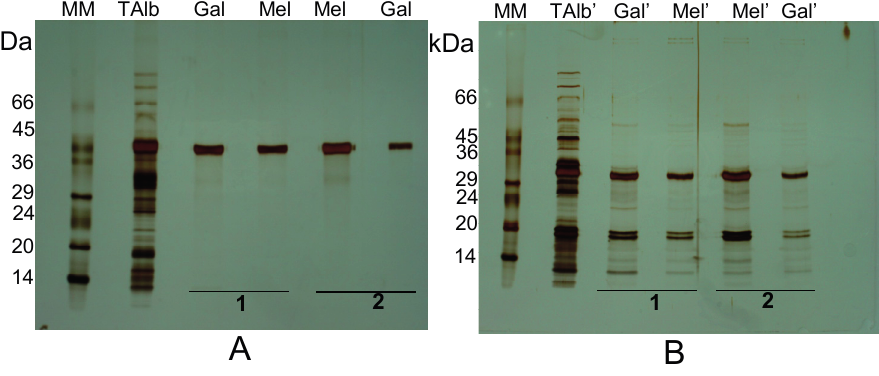
Figure 2. Electrophoretic profile of the galactose-eluted 42 kDa subunit bound to erythrocyte membranes, performed under non-reducing ( A , NR-SDS-PAGE) and reducing conditions ( B , R-SDS-PAGE). Two separate but identical sets of erythrocyte membranes were incubated with lupine total albumins (lanes TAlb and TAlb’) and submitted to sequential elution by 0.4 M galactose (elution 1, lanes Gal and Gal’) followed by 0.4 M melezitose (elution 1, lanes Mel and Mel’), or melezitose (elution 2, lanes Mel and Mel’) followed by galactose (elution 2, lanes Gal and Gal’). Molecular masses of standards (MM) are indicated in